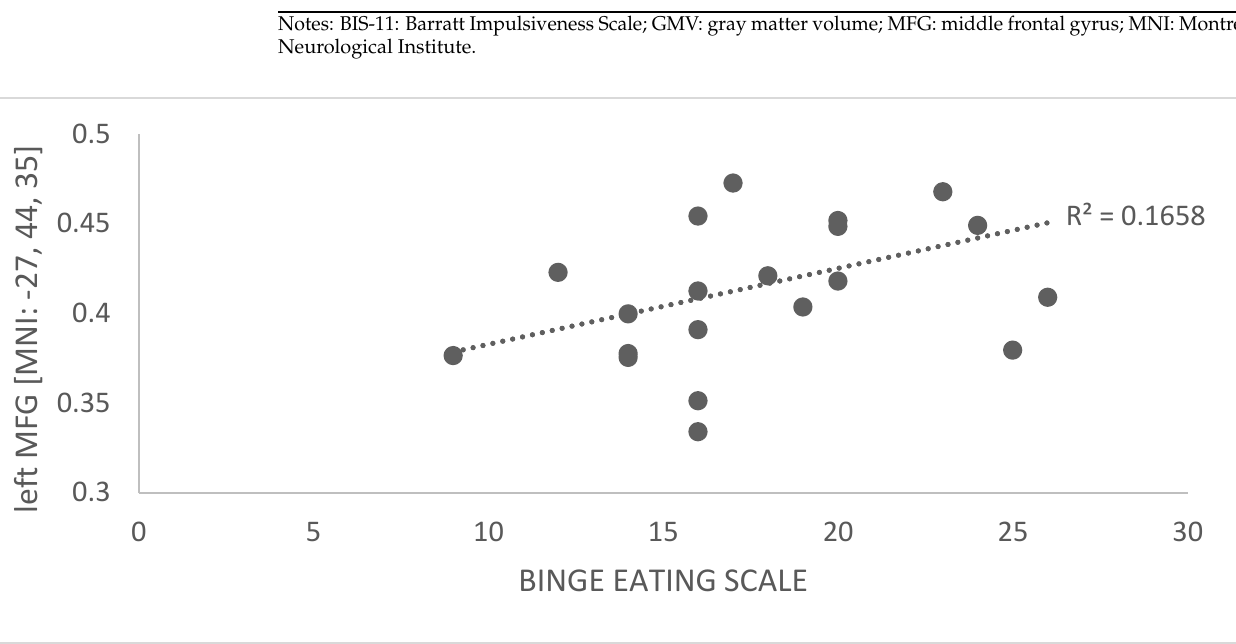
Figure A1. Correlation between BES scores and GMV in the left MFG, in the BE group. Notes: BES: binge-eating scale; GMV: gray matter volume; MFG: middle frontal gyrus; MNI: Montreal Neurological Institute.